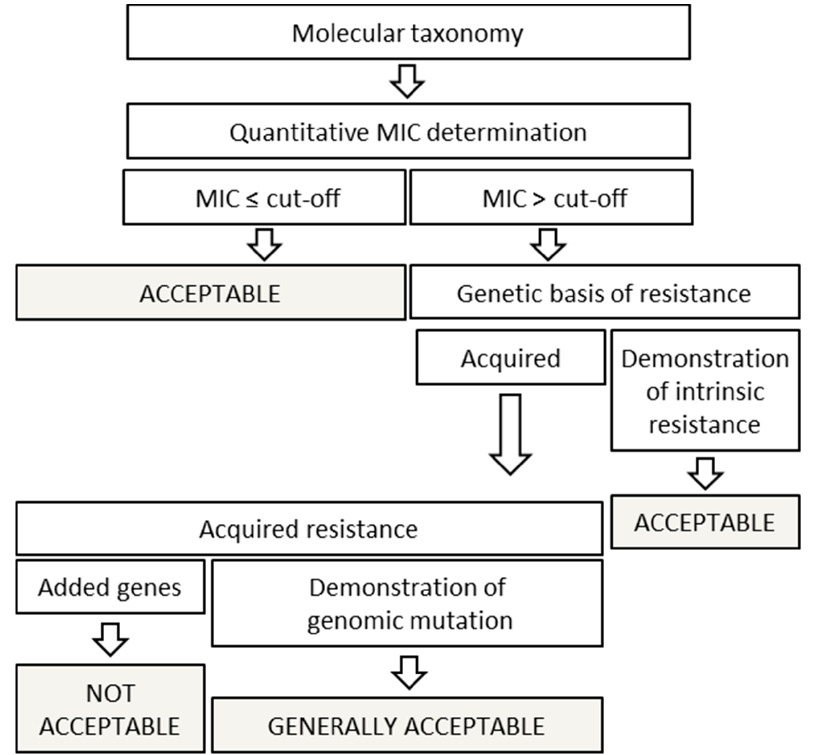
Figure 3. Proposed scheme for the antimicrobial resistance assessment of a bacterial strain (MIC: Minimal Inhibitory Concentration).